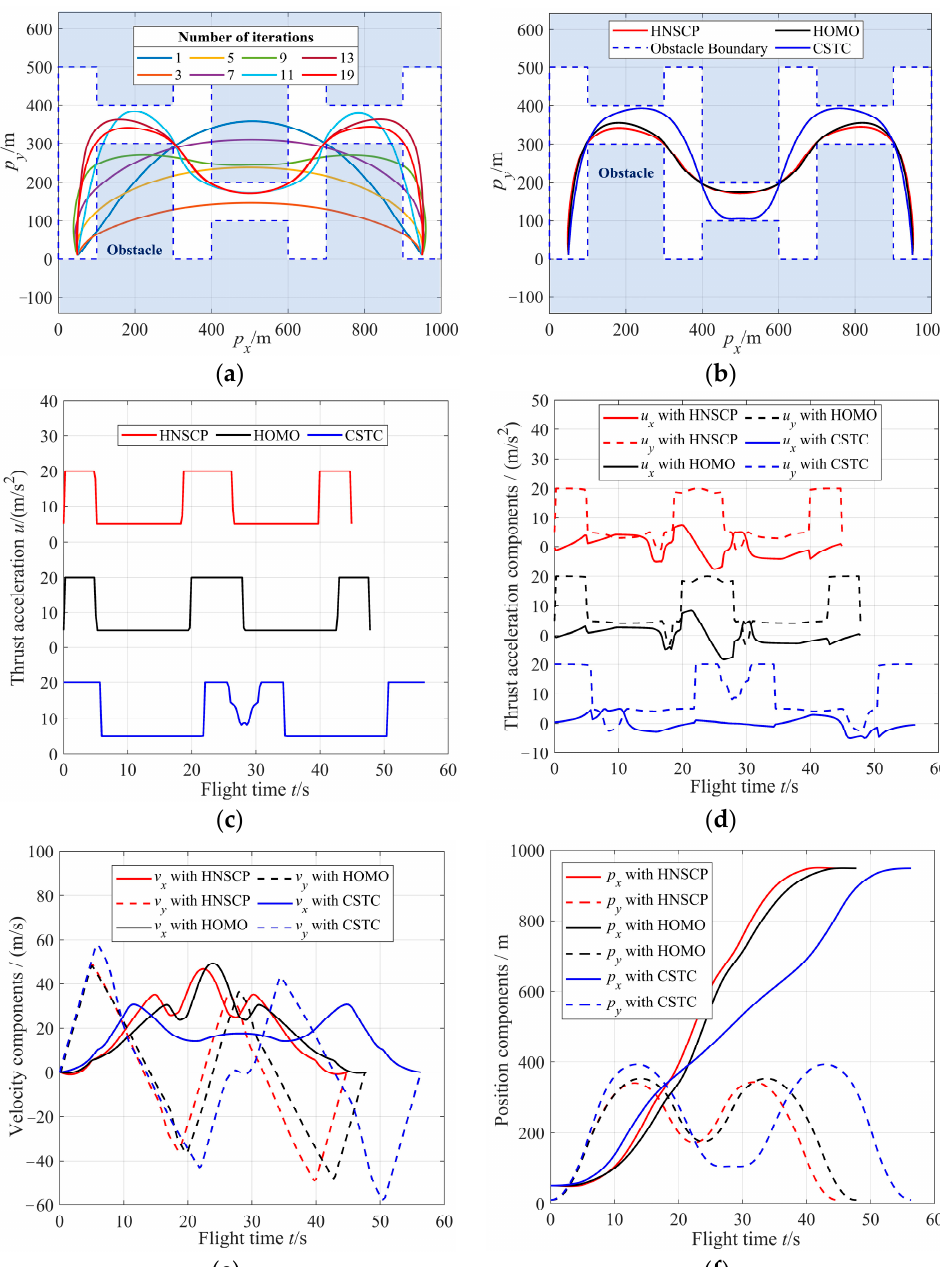
Figure 6. Example 1 ′ s MSD fields with different homotopy parameters. ( a ) ε= 0.0 , ( b ) ε= 0.33 , ( c ) ε= 0.67 , and ( d ) ε= 1.0 .